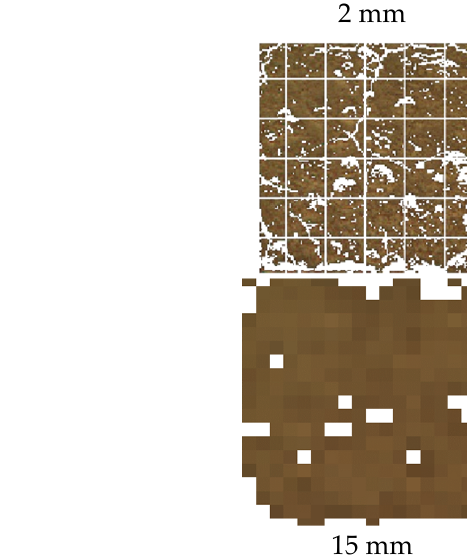
Figure A2. Example of soilbox image (false colour RGB composite) before de-shadowing ( left ), and after de-shadowing at 2 mm resolution ( top right ) and 15 mm resolution ( bottom right ). For all soil samples, the percentage amount of pixel removed for the same soil sample between the 2 mm and the 15 mm resolution was compared (Figure A3, left). The relative percentage difference between the removal amount in the two resolutions (Figure A3 right) showed that the majority of samples got almost the same amount of pixels removed (between the − 20% and + 20% difference).